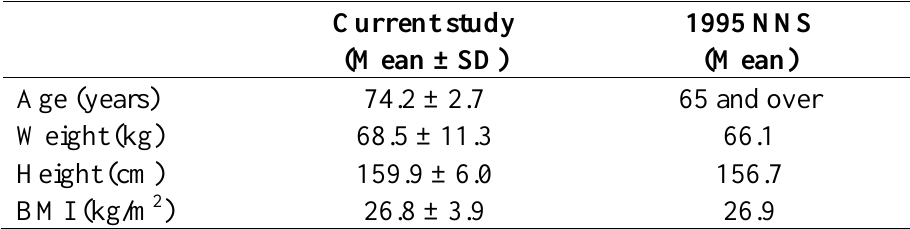
Table 1. Characteristics of participants in the current study (n = 218) and in the National Nutrition Survey (NNS) in 1995, Australia.